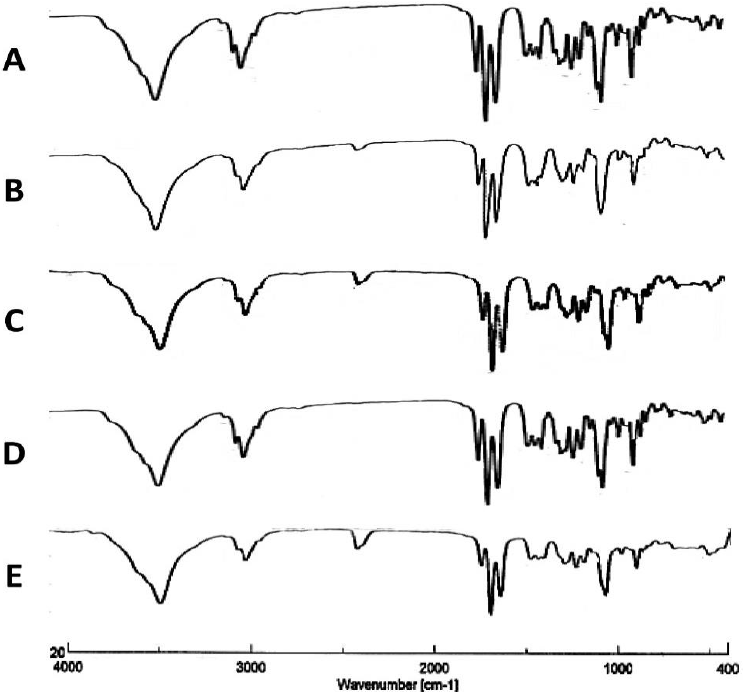
Figure 7. FTIR scans of different TAA formulations. ( A ) Micronized TAA raw material unprocessed and ( B ) 1% ( w / v ) TAA/ammonium bicarbonate (90:10), ( C ) (85:15), and ( D ) (80:20) and ( E ) 1.5 ( w / v ) % TAA/ ammonium bicarbonate (90:10) products spray-dried from 90% ( v / v ) ethanol.